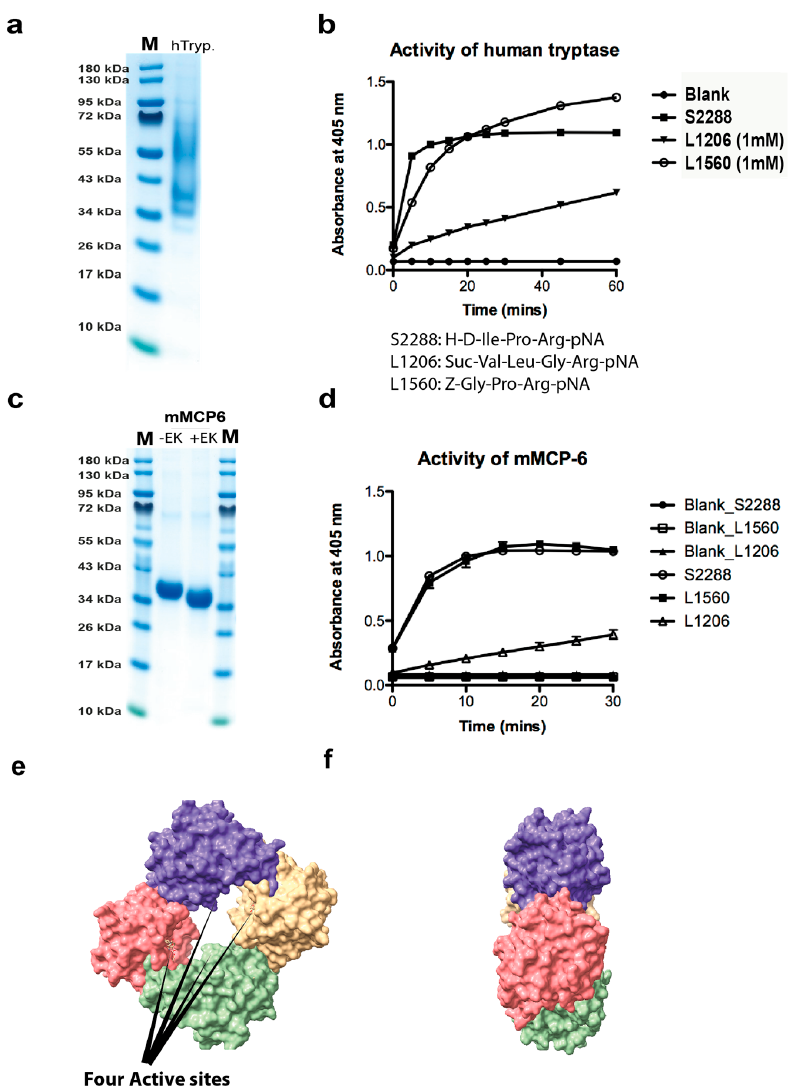
Figure 1. Analysis of the recombinant human and mouse mast cell tryptases used for the substrate analysis by SDS-PAGE and chromogenic substrate assay. ( a ) Approximately two micrograms of the recombinant human tryptase was separated on a 4–12% gradient SDS-PAGE gel and stained with colloidal Coomassie blue solution. Several bands starting at approximately 36 kDa up to almost 70 kDa were seen, indicating heterogenous glycosylation. ( b ) The activity of the human recombinant tryptase was assayed against three different chromogenic substrates. All three are substrates for tryptic enzymes due to the Arg in the P1 position. The human tryptase showed good activity against all three, but the best activity against the two substrates occurred when the Arg was preceded by a Pro residue. ( c ) The purified recombinant mouse mast cell tryptase (mMCP-6) before and after enterokinase cleavage. ( d ) The activity of the mouse recombinant tryptase was assayed against three di ff erent chromogenic substrates. The substrate preference for the mouse enzyme was almost identical to its human counterpart shown in ( b ). ( e , f ) Three-dimensional structural models of the human tryptase tetramer (PDB No: 2fs9). The space filling model of the human MC tryptase is shown from two angles, from the front looking into the tetramer and from the side [20]. The four active sites in the middle of the tetramer are marked by four arrows. The pictures were visualized in the UCSF Chimera